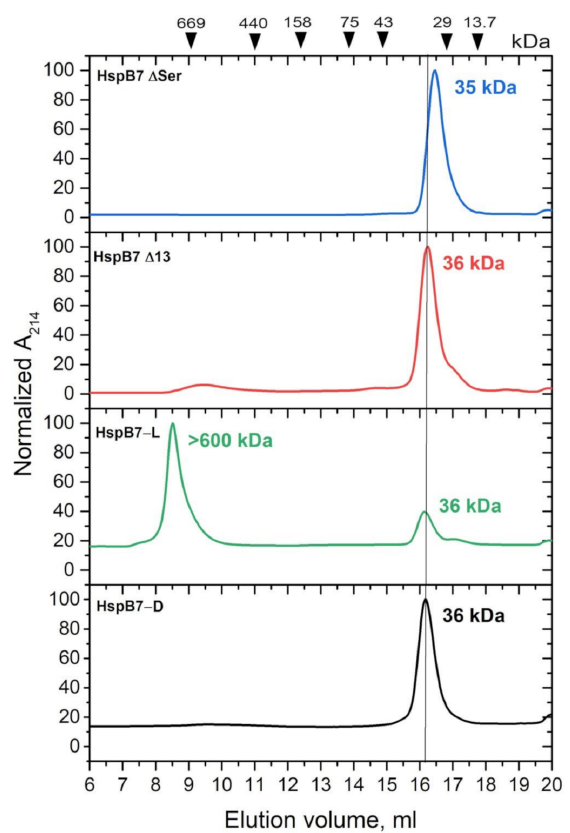
Figure 4. Normalized SEC elution profiles of the wild-type HspB7-D, HspB7-L, ∆ 13, and ∆ Ser mutants of HspB7. Elution volumes and apparent molecular weights of protein standards (kDa) are indicated at the top of the